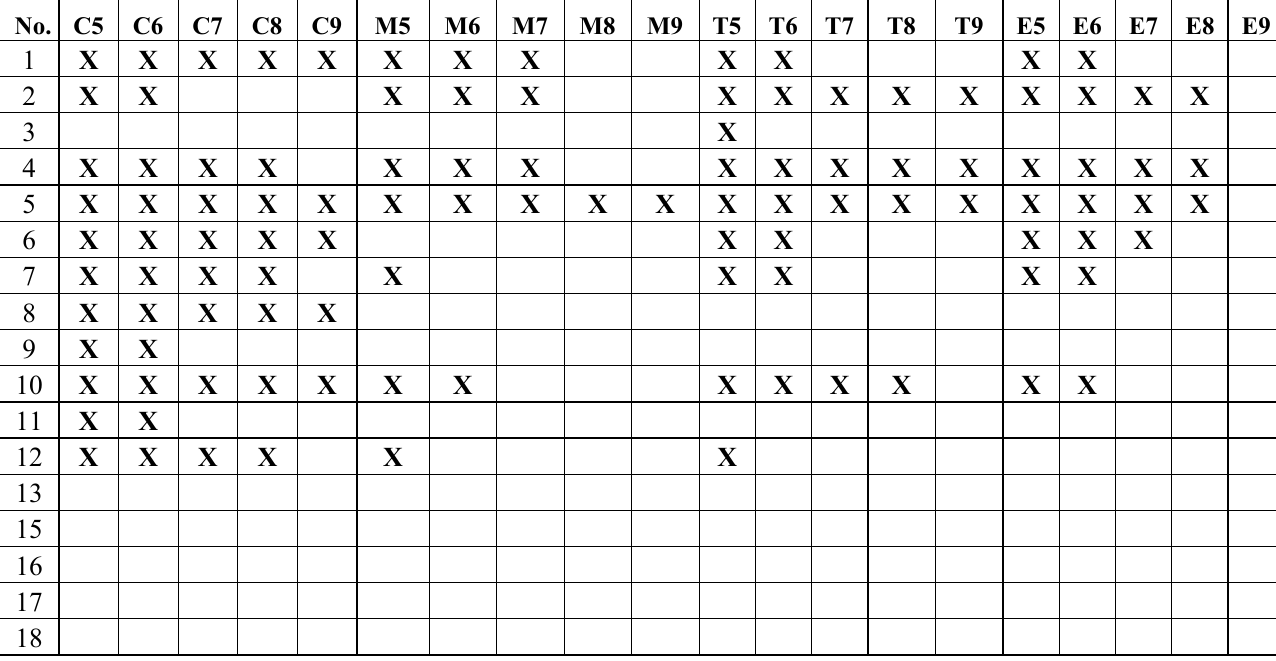
a C5, C6, C7, C8 and C9 denote PASS predicted probabilities for the compound being carcinogenic higher than 50, 60, 70, 80 and 90%, respectively. Analoguously for M (mutagenic), T (teratogenic) and E